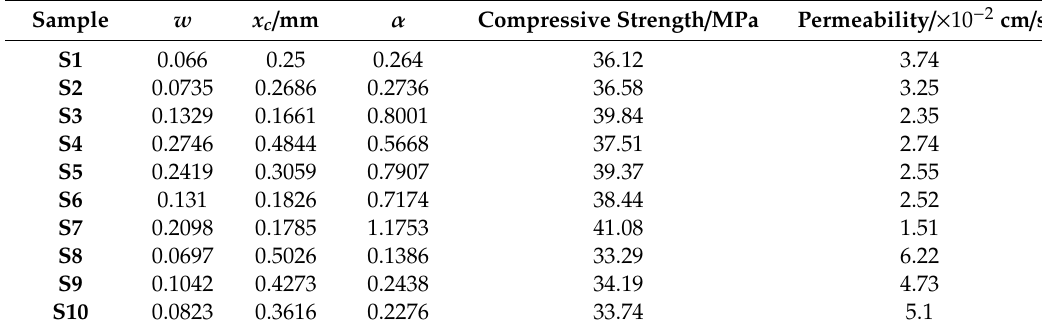
Table 5. Particle group distribution data and sample properties.